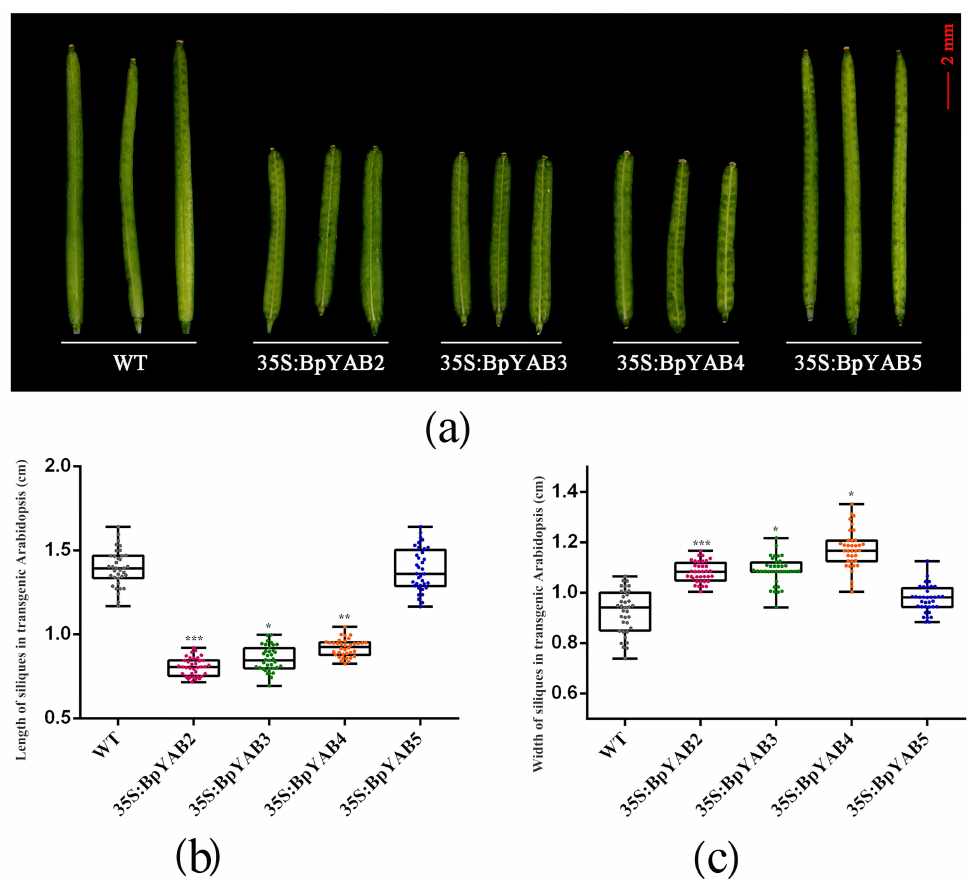
Figure 8. Effects on siliques in A. thaliana by ectopic overexpression of BpYAB2 , BpYAB3 , BpYAB4 , and BpYAB5 . ( a ) Morphology of siliques in A. thaliana . ( b ) Length of siliques in A. thaliana . ( c ) Width of siliques in A. thaliana . * means p less than 0.05, ** represents p < 0.01 and *** represent p <